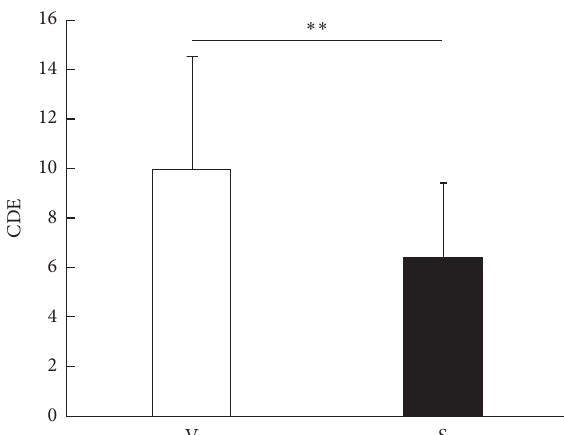
Figure 2: Comparison of the cumulative dissipated energy (CDE). The intraoperative CDE is compared between the two groups. It is significantly higher in the V group than the S group ( p � 0 . 006; Mann–Whitney U test; ∗∗ p < 0 . 01). V � V group and S � S group.